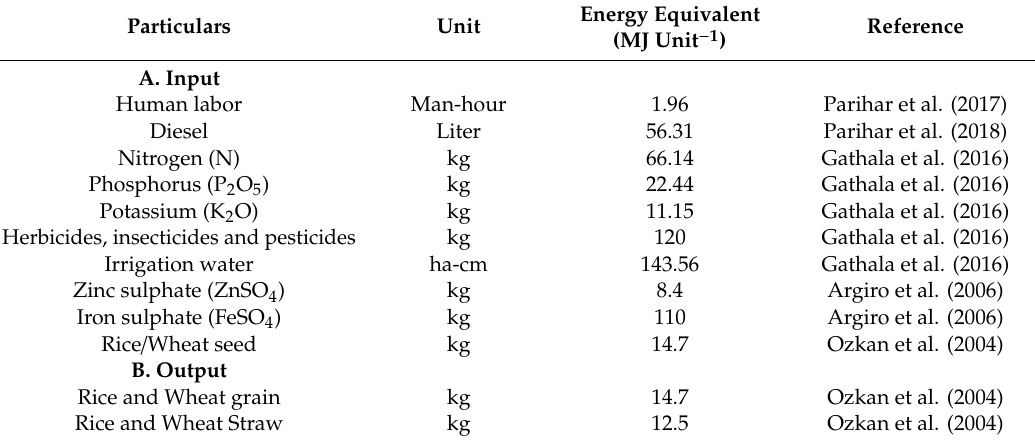
Table 5. Energy equivalents used for calculation of energy input and output in this